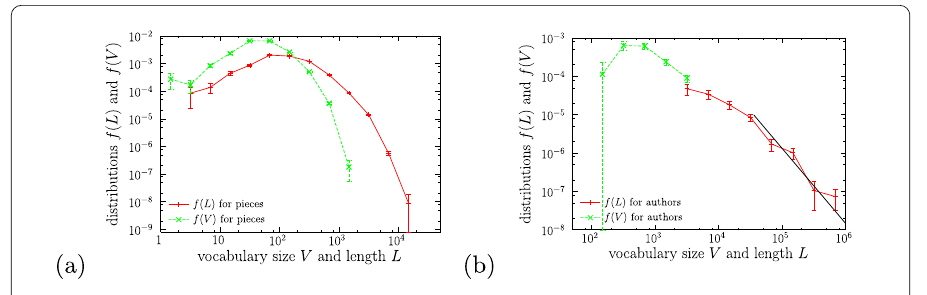
Figure 2 Probability mass functions of length L and vocabulary size V . ( a ) For individual pieces. ( b ) For individual authors. A power-law fit to the tail of f ( L ) is shown as an indication (straight line), with an